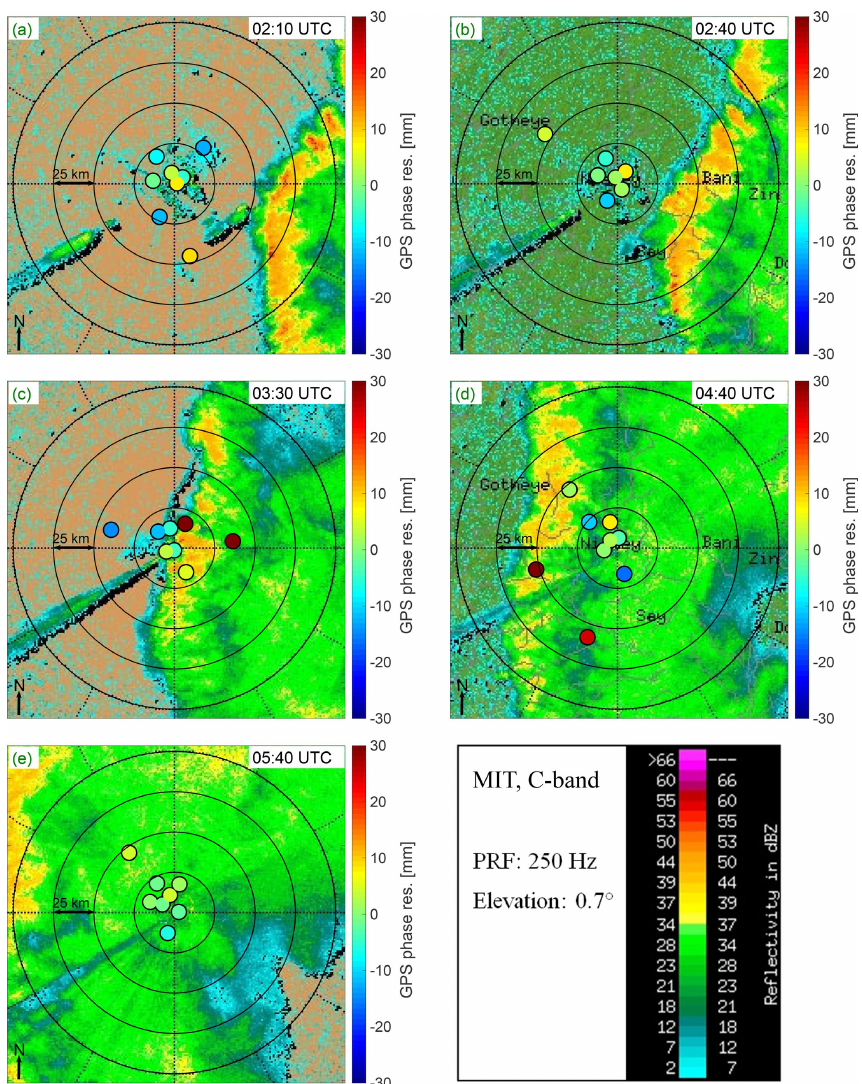
Figure 6. Reflectivity maps from the MIT C-band Doppler radar in Niamey at (a) 02:10UTC, (b) 02:40UTC, (c) 03:30UTC, (d) 04:40UTC, and (e) 05:40UTC on 11 August 2006, showing a squall-line MCS approaching from the east and passing straight over the site at 03:30UTC. Post-fit phase residuals from GPS data processing are superposed on the maps using the GIPSY-OASIS software at the exact times of the radar plots. The radar reflectivity color bar is in the lower right-hand panel. The GPS residual color bar is attached to each panel. The GPS phase residuals are projected on the radar maps in the directions of the satellite-receiver paths, assuming a 10km troposphere thickness and a spherical Earth with a 6400km radius. The concentric circles indicate the distance from the GPS station’s location at 25km